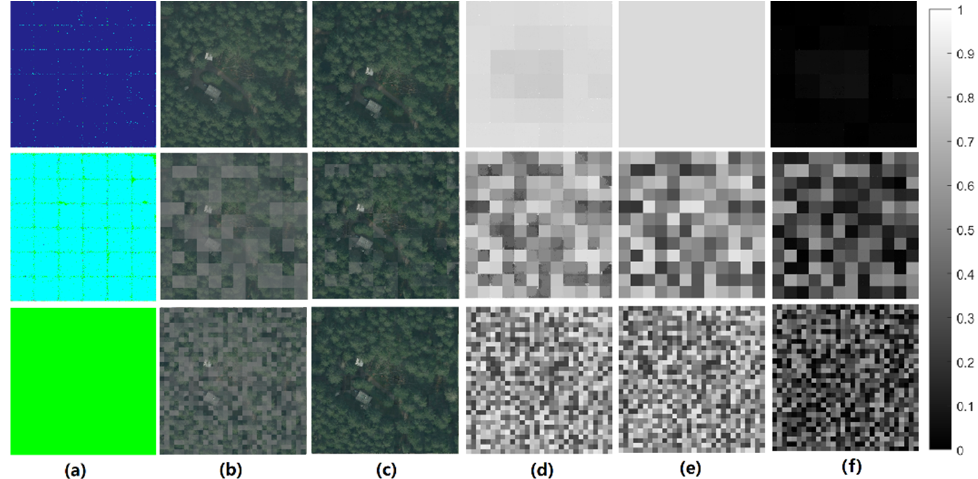
Figure 6. One-step DRL_Dehaze results of different haze scales in forest area. The first row presents the uniform-haze situation, the second row presents the medium-scale haze situation, and the last row presents the small-scale haze situation. ( a ) Action maps of the hazy aerial image, ( b ) hazy aerial image, ( c ) dehazed clear image of ( b ), ( d ) predicted atmosphere transmission map, ( e ) ground truth values of the atmosphere transmission maps, and ( f ) differences in the predicted and true atmosphere transmissions. The bar on the right provides reference values for ( d )–( f ).